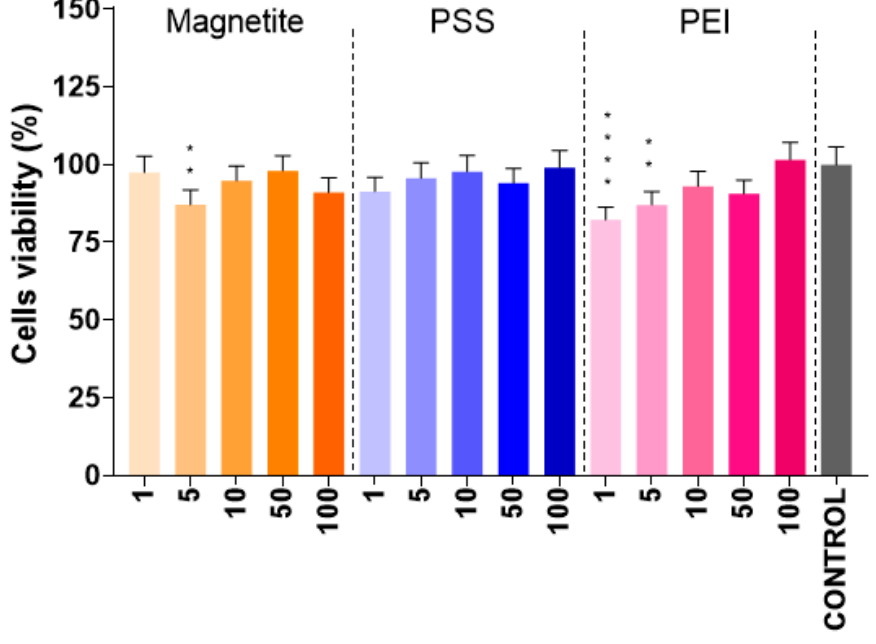
Figure 8. Results of the cell viability MTT test for N2A cells incubated with parent and modified IONs. The abscissa numbers represent concentration of nanoparticles (in µg·L − 1 ); the p values (<0.01 and <0.0001) are marked, respectively, with, two, and four asterisks.